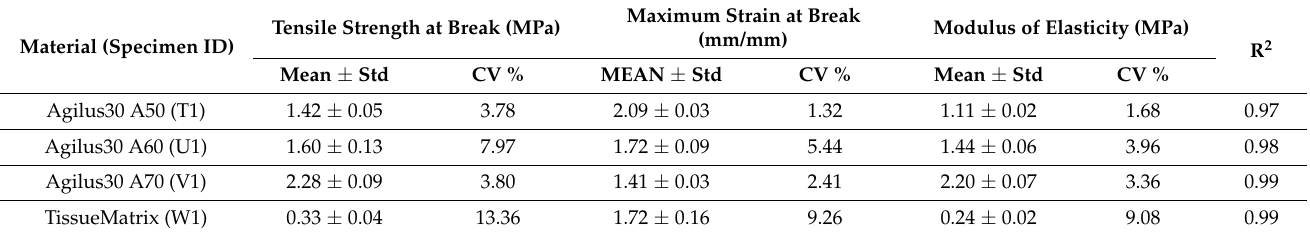
Table A1. The mechanical properties of base PolyJet materials. Mean ± standard deviation (std) values, coefficient of variation (CV%), and Pearson’s coefficient (R2) are reported.